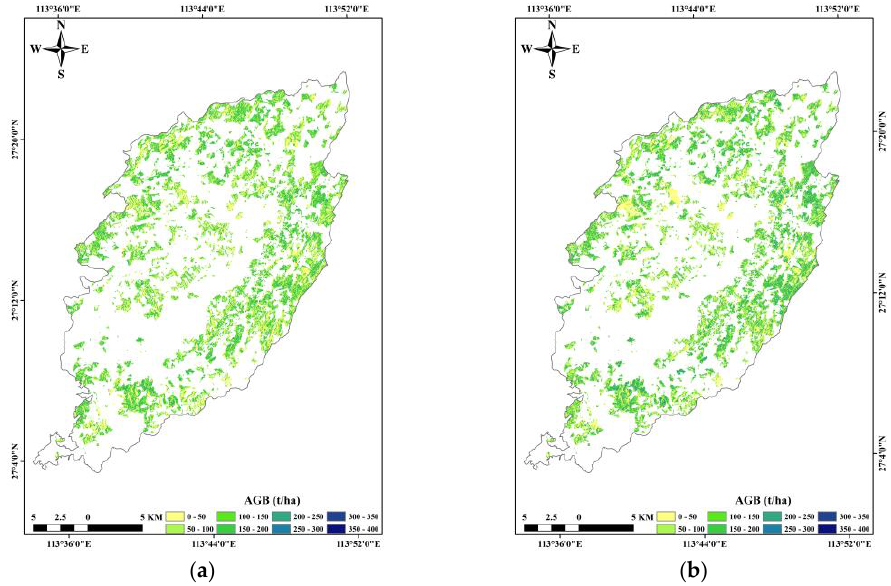
Figure 12. Maps of forest AGB used images acquired on 16 June ( a ) and 30 June ( b ).